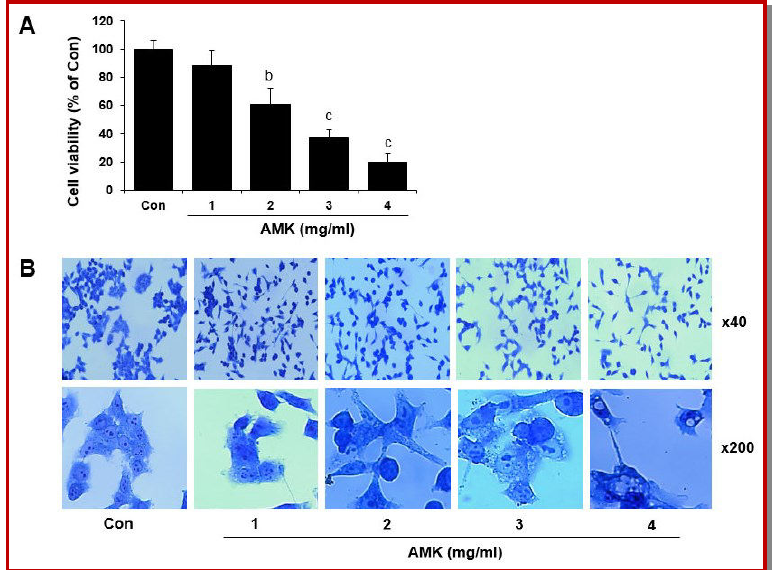
Figure 1: Effects of A. macrocephala (AMK) on the cell viability and histomorphologic evaluation of KB cells. (A) Cells were treated with various concentrations of A. macrocephala (1-4 mg/mL) for 24 hours. Cell viability was analyzed using an MTT assay. b p<0.005 and c p<0.0005 vs. the untreated-control (Con). (B) The cells were then stained with Diff-Quick and observed by fluores- cence microscopy with low magnification (40x) and high magnification